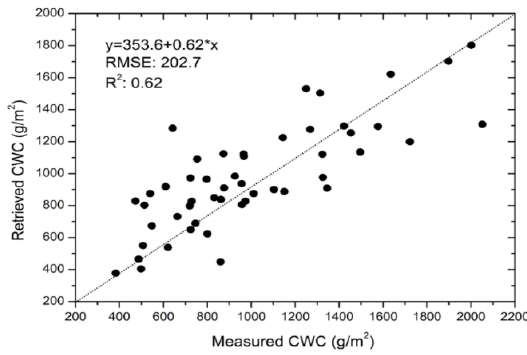
Figure 5. The scatterplot of the retrieved CWC versus ground-measured